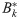
The Bk- and Bk*-branches for k ≥ 1.